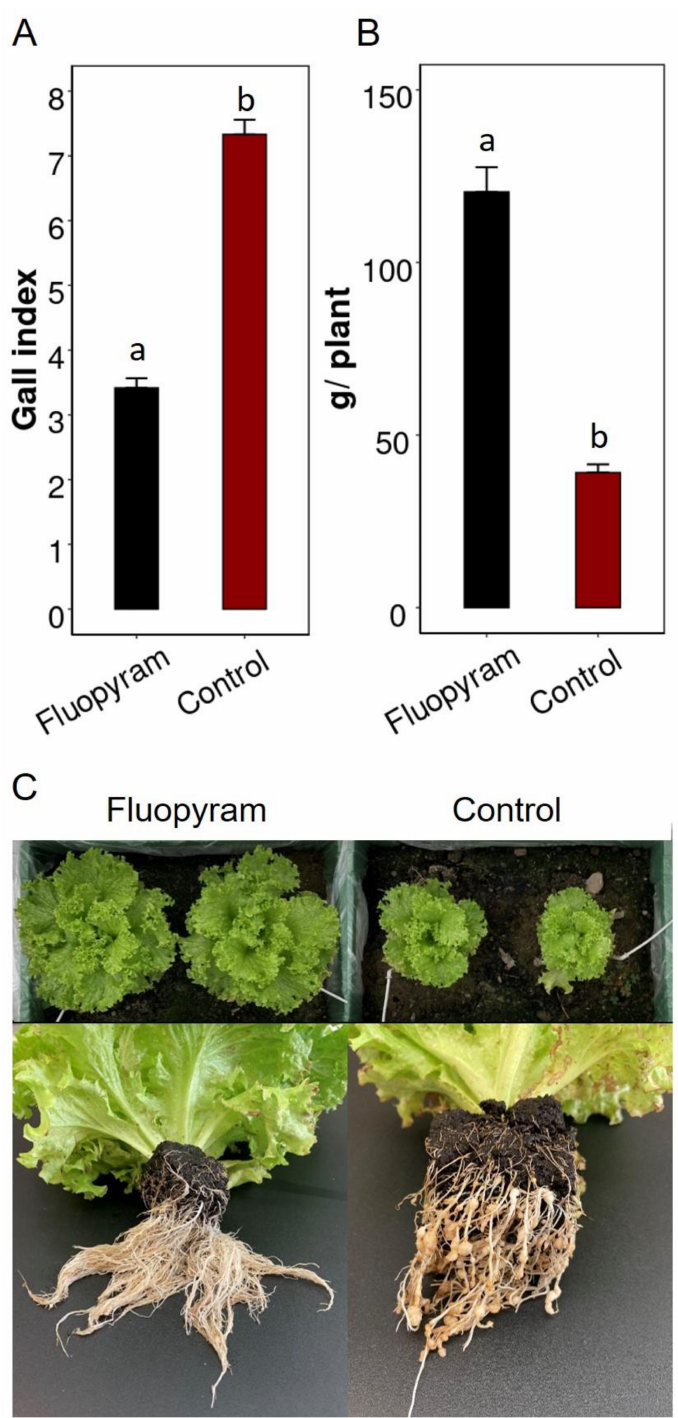
Figure 5. Effect of planting hole treatment with fluopyram on lettuce root-gall rating ( A ) and lettuce weight ( B ) grown in soil infected with Meloidogyne incognita (500 J2s/100 cc of soil). Representative photos ( C ) show the differences between lettuce treated with fluopyram and untreated (top) and lettuce roots (bottom). Root galling was indexed according to Zeck’s scale of root-knot infection [19], with 0 = no root galls and 10 = severe galled-up root (n = 12). Different letters indicate significant differences compared to the control according to a one-way ANOVA with post-hoc Tukey HSD test ( p ≤